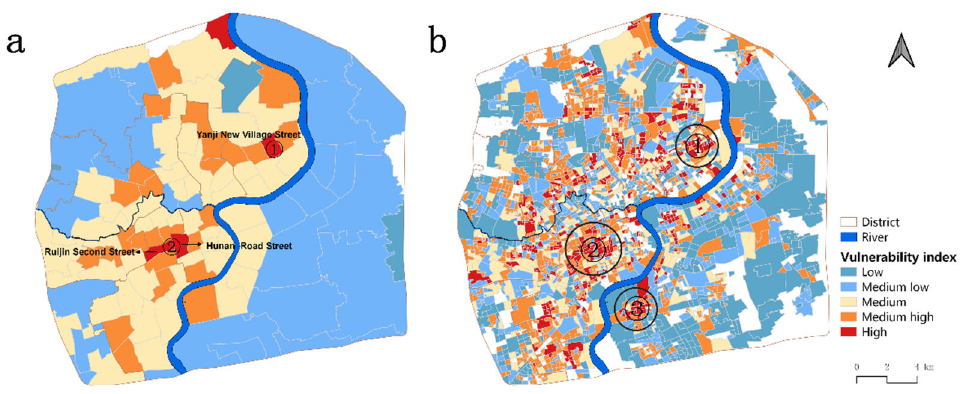
Figure 8. Distribution of vulnerability indexes at the ( a ) sub-district and ( b ) neighborhood commit- tee scales.